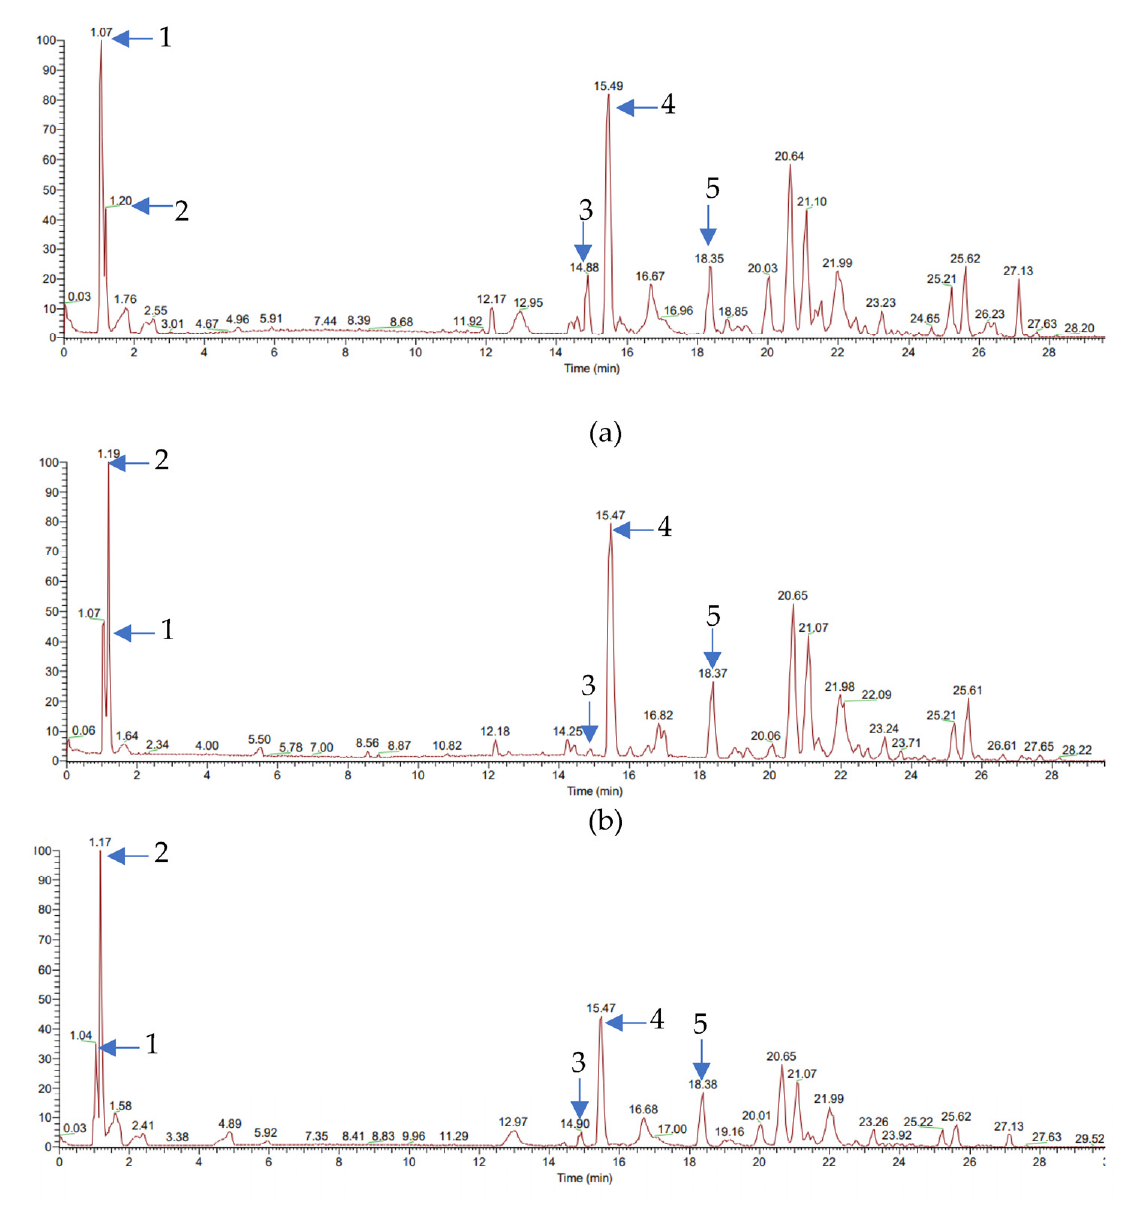
Figure 1. LC–MS/MS chromatogram of ( a ) GG, ( b ) MM, ( c ) EE rhizome extract, peak 1 (choline), peak 2 (D–(+)–pipecolinic acid), peak 3 (6–paradol), peak 4 (6–gingerol), and peak 5 (8–shogaol).